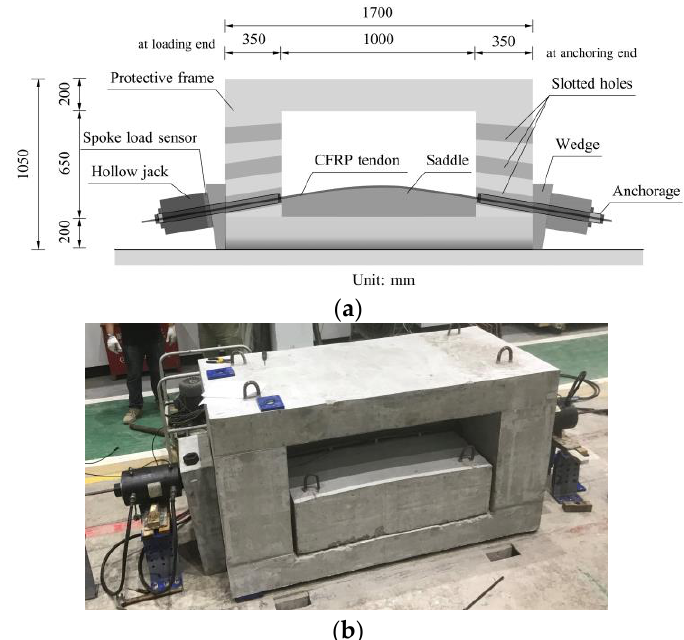
Figure 5. Test loading device: ( a ) schematic; ( b ) photograph (mm).